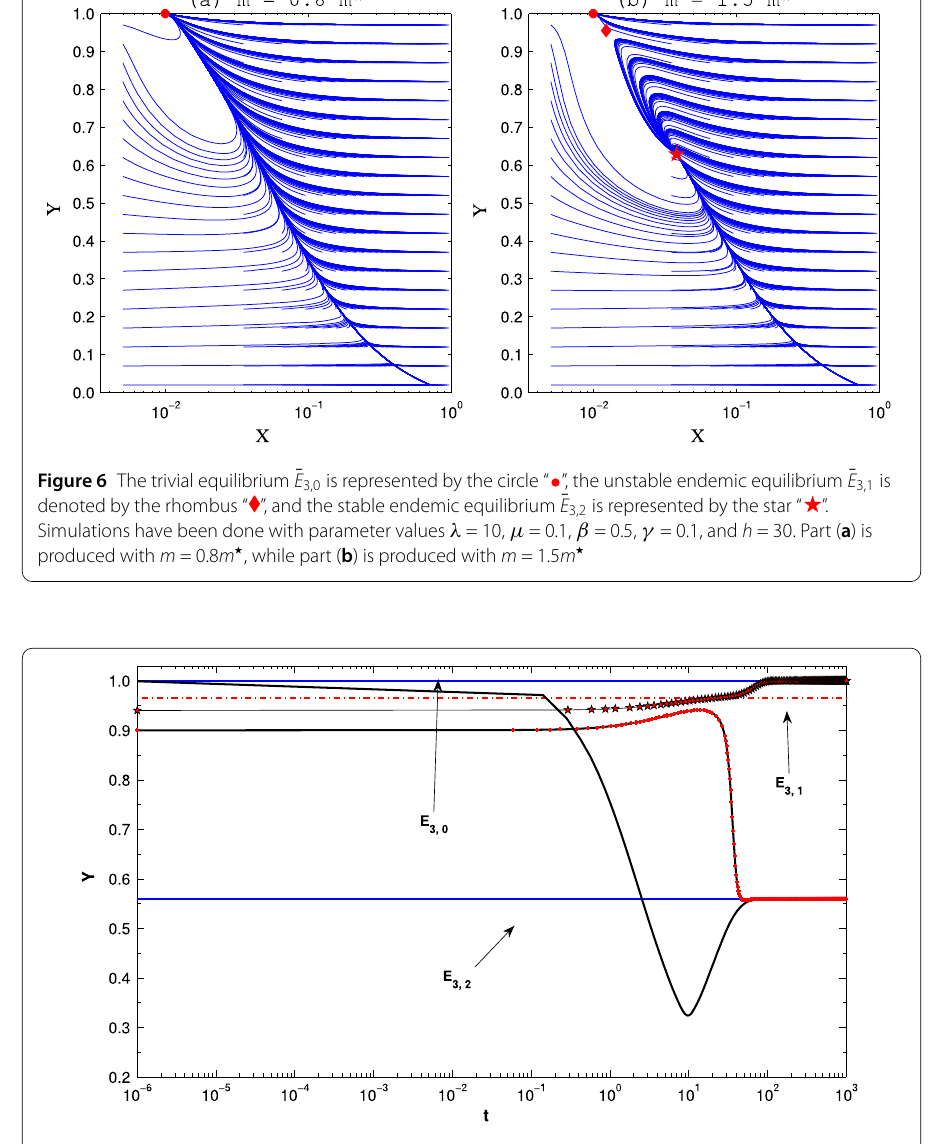
Figure 7 Time-series analysis for model (17) with parameter values λ = 10, μ = 0.1, β = 0.5, γ = 0.1, h = 30, and m = 1.8 m (cid:6) . The solid horizontal lines correspond to the stable equilibria ( ¯ E 3,0 for the higher line and ¯ E 3,2 for the lower line), while the dashed-dotted horizontal line corresponds to the unstable equilibrium ¯ E 3,1 . The trajectory of solid curve signed with stars “ ” is produced with initial values X = 0.03 and Y = 0.94, while that signed with pluses “ ” has initial data X = 0.0001 and Y = 0.999. The sign-free solid trajectory curve is produced with initial conditions X = 0.1 and Y =